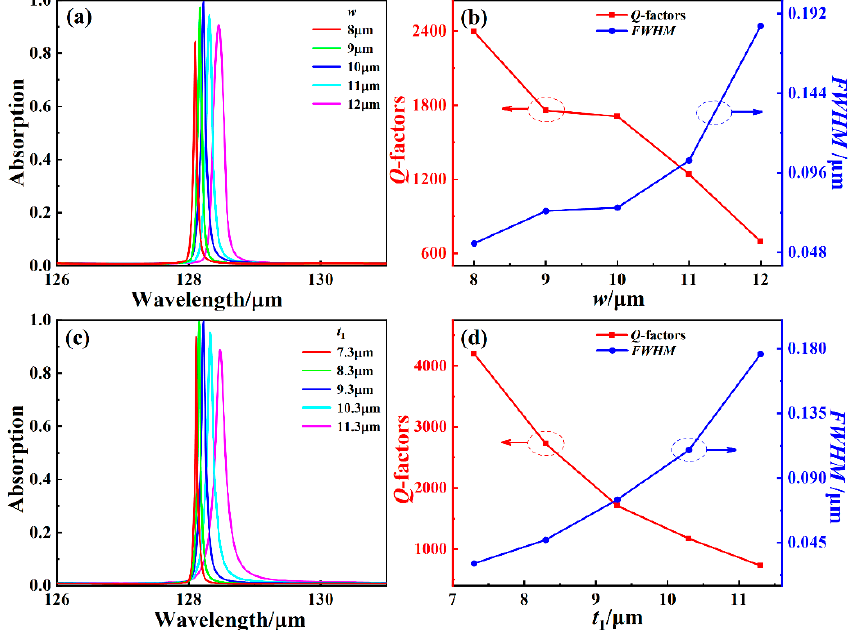
Figure 6. Absorption spectra at different widths w ( a ) and thicknesses t 1 ( c ), respectively. Q -factor and FWHM of the absorption spectra with varying widths w ( b ) and thicknesses t 1 ( d ), respec- tively.